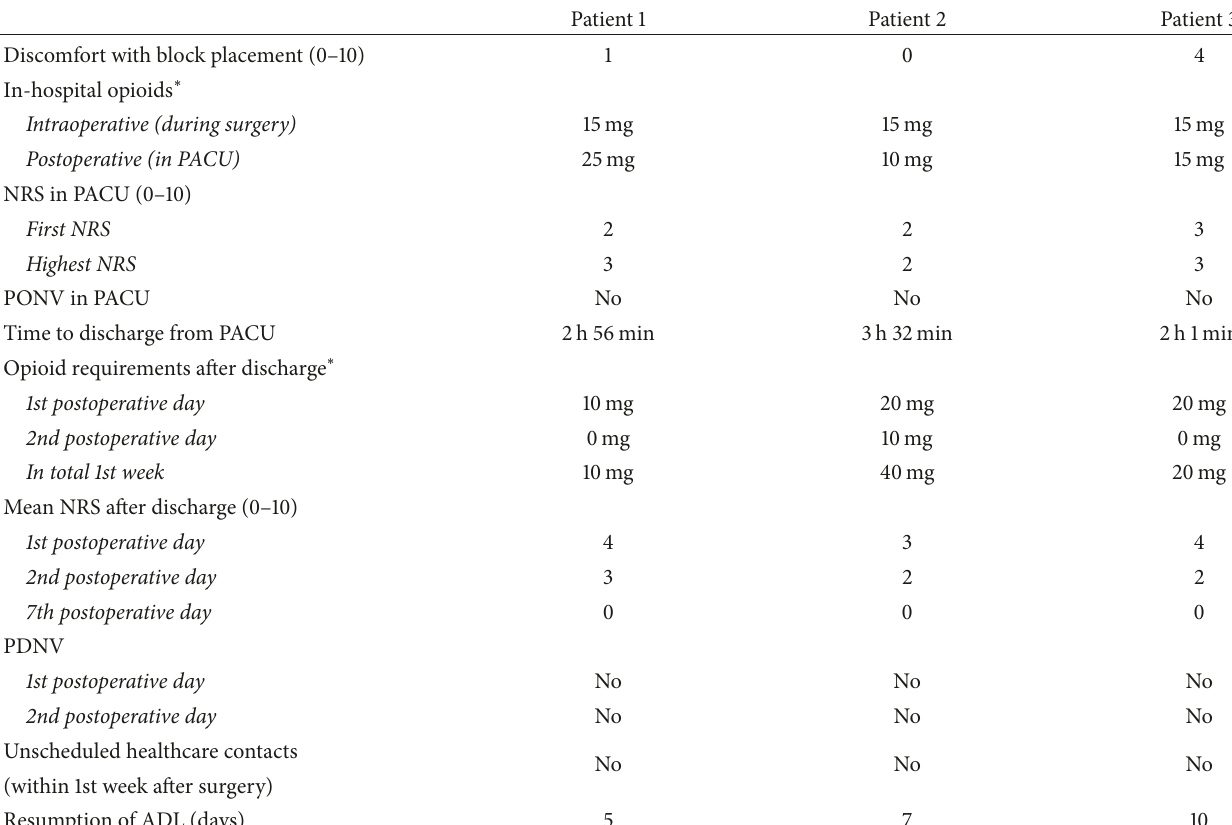
Table 1: Data from all three patients on opioid consumption, pain scores, and other